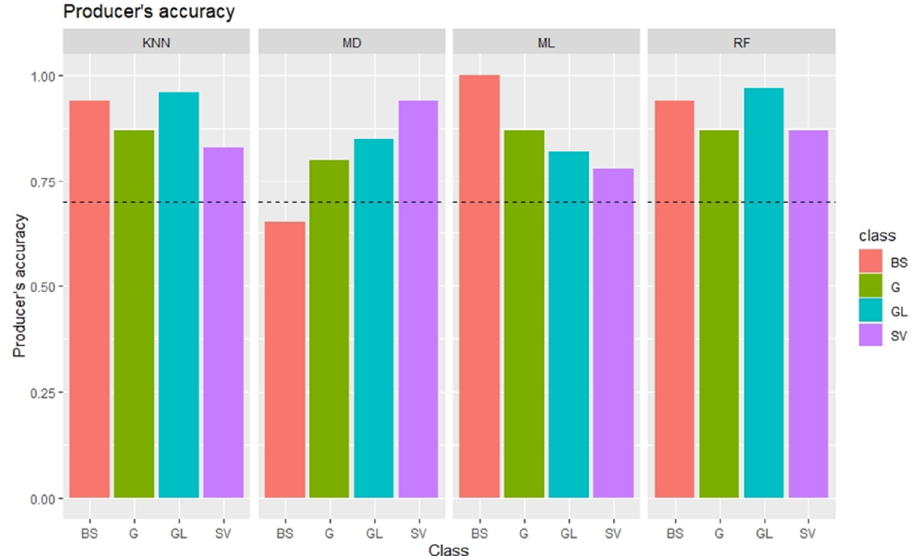
Figure 5. User’s accuracy and producer’s accuracy (dashed black line indicates class accuracy benchmark of 0.70; GL: grassland, SV: stressed vegetation, G: gully, BS: bare soil). benchmark of 0.70; GL: grassland, SV: stressed vegetation, G: gully, BS: bare